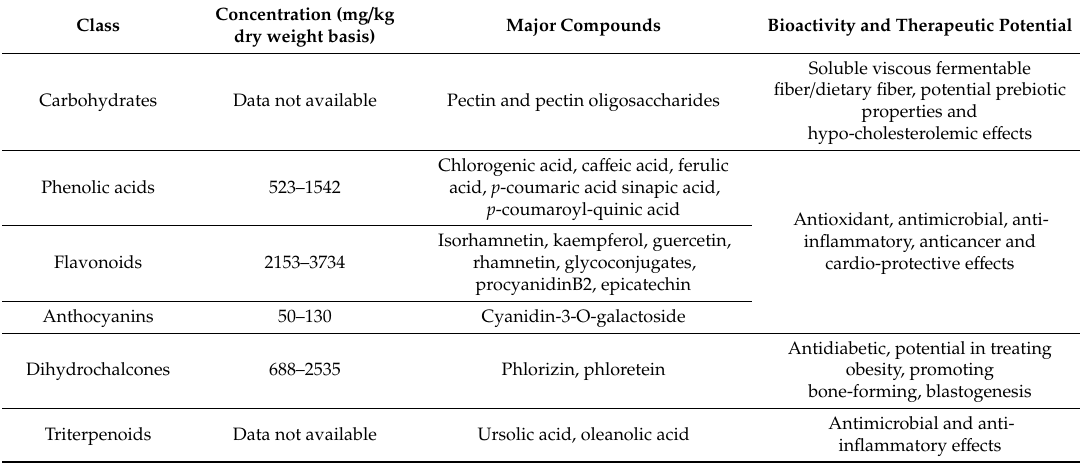
Table 3. Major bioactive compounds from apple